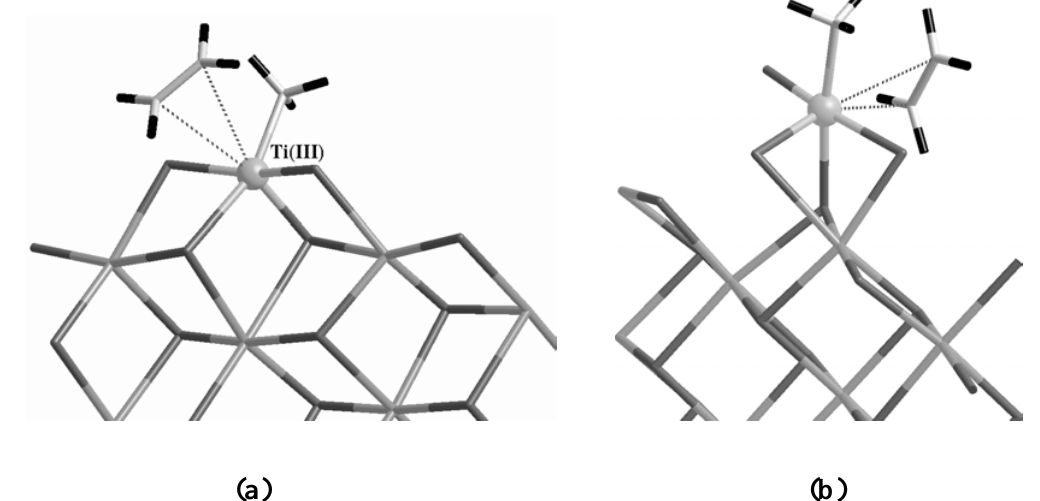
Figure 4. The active Corradini (a) and 5-fold (b) sites forming a π -complex with an ethylene molecule. The Ti atom is evidenced as a gray ball while H atoms are the terminal black sticks on both the ethyl- ene and the methyl group bound to Ti. The label in parentheses in (a) indicates the formal oxidation state of Ti.